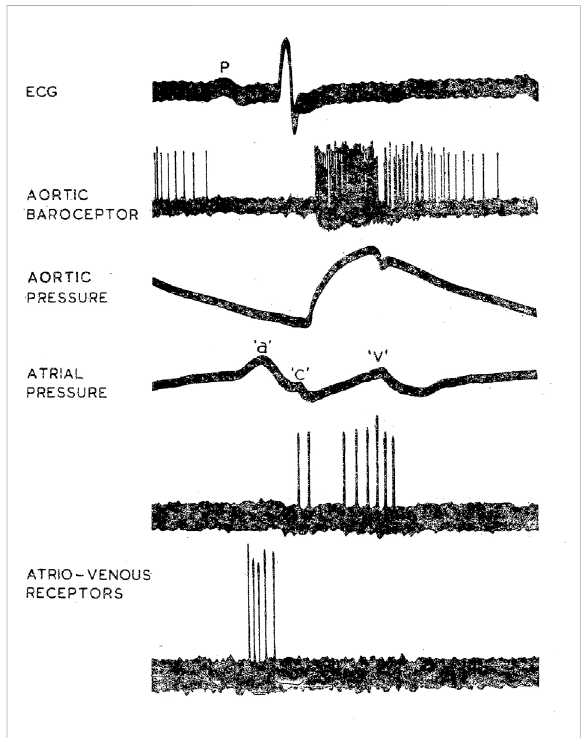
FIGURE 1 Characteristic discharge patterns in relation to ECG and pressure pulse in myelinated vagal “ high-pressure ” and “ low- pressure ” mechanoreceptors in the dog. The aortic BR was near the origin of the left subclavian artery. Activity in the upper of the two atrio-venous recordings arose from an ending (type B) at the junction of right atrium and superior vena cava; activity in the lowertracecamefromanending(typeA)inthesuperiorvenacava just inside the pericardium. [Figure 1 (Coleridge et al.,